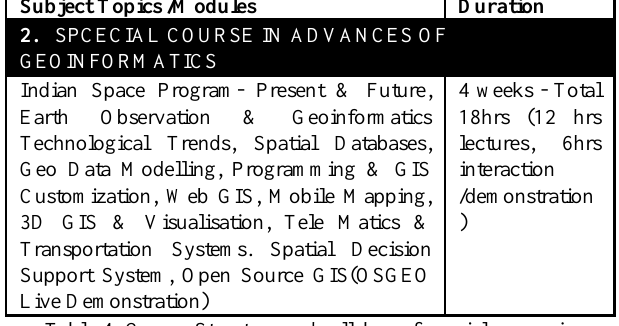
Table 4: Course Structure and syllabus of special course